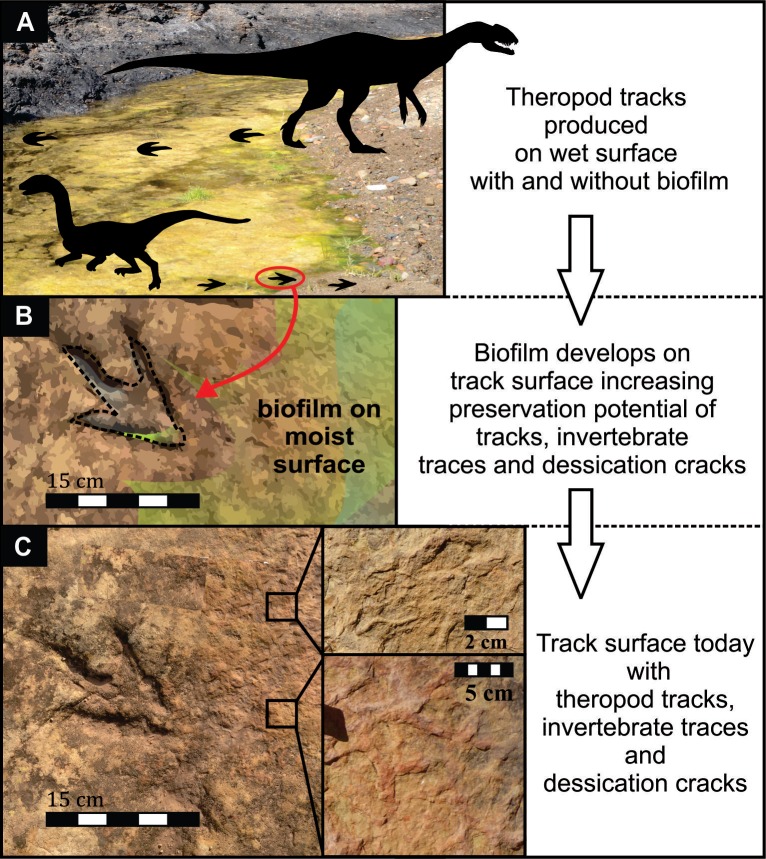
Model of the formation and preservation of tracks at the Mafube dinosaur track site.Not to scale. Dracovenator outline adapted from https://commons.wikimedia.org/wiki/File:Dracovenator3.png.